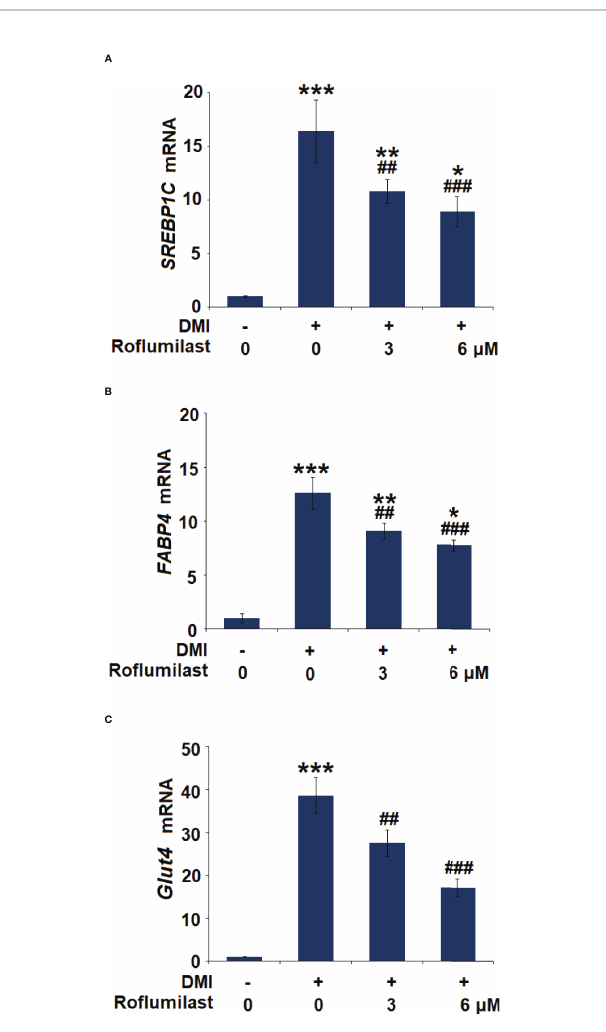
FIGURE 4 | Effects of Ro fl umilast on the expression of adipogenic genes. Cells were incubated with a differentiation cocktail (DMI) medium with Ro fl umilast (3 and 6 m M). (A) mRNA of SREBP1C; (B) mRNA of FABP4; (C) mRNA of Glut4 (*, **, ***, P < 0.05, 0.01, 0.005 vs. vehicle group; ## , ### , P < 0.01, 0.005 vs. DMI group, n = 6).